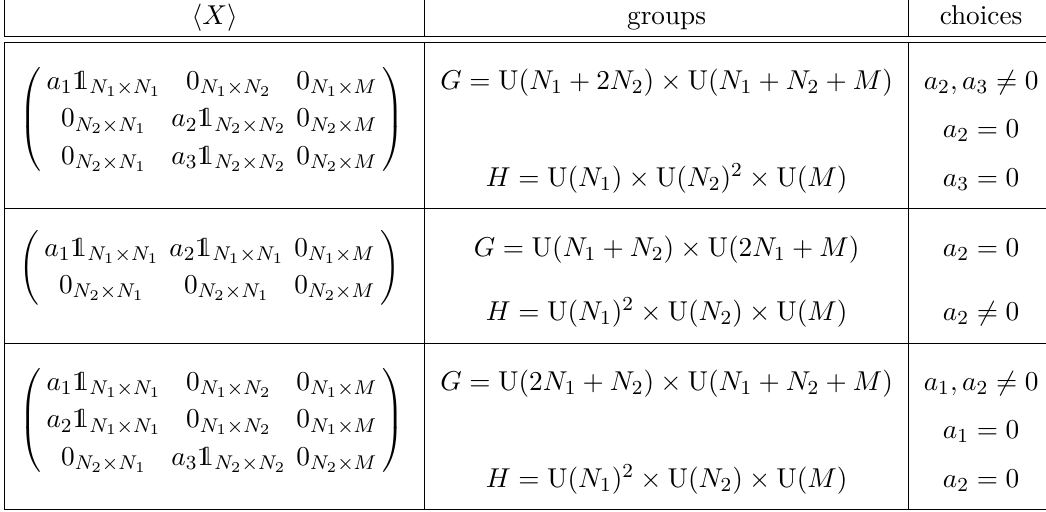
Table 2 . Breaking patterns of bi-fundamental matter fields X for convenient block-like